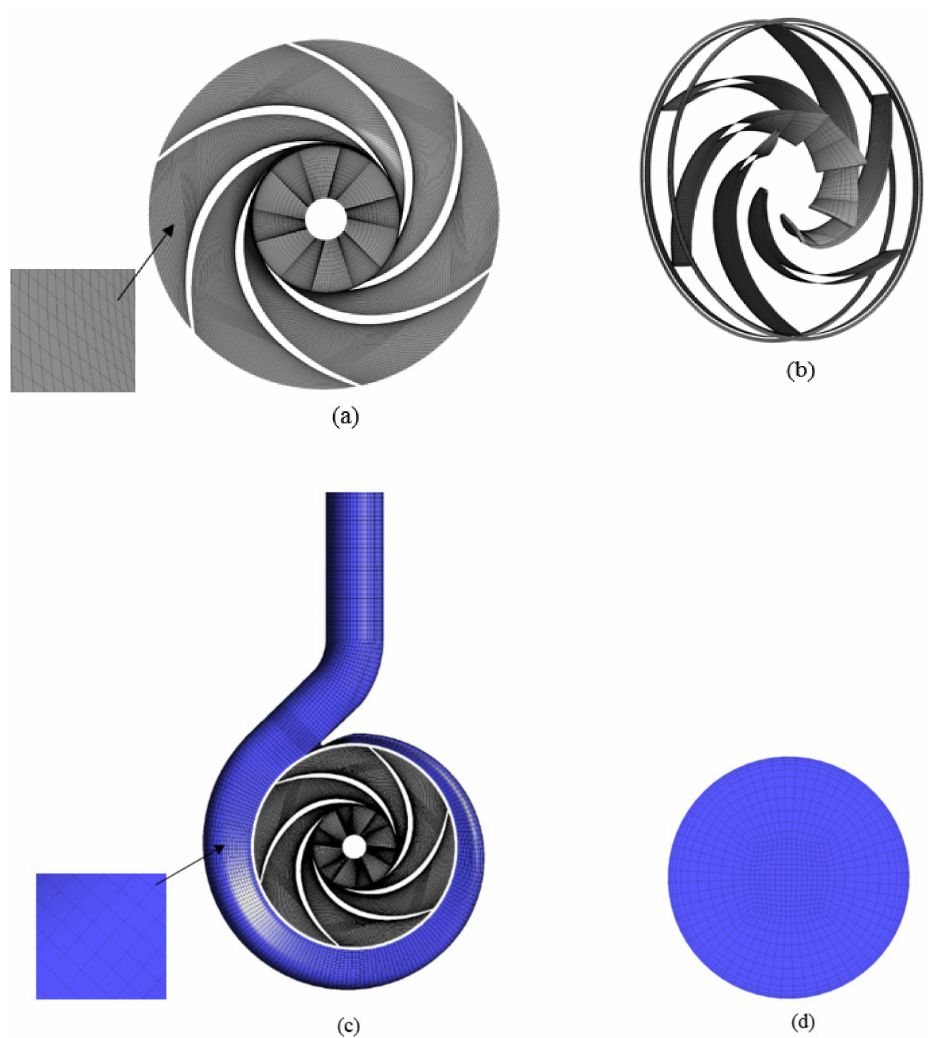
Figure 3. Computational grid domains. ( a ) Shroud, ( b ) impeller blades, ( c ) volute, ( d )